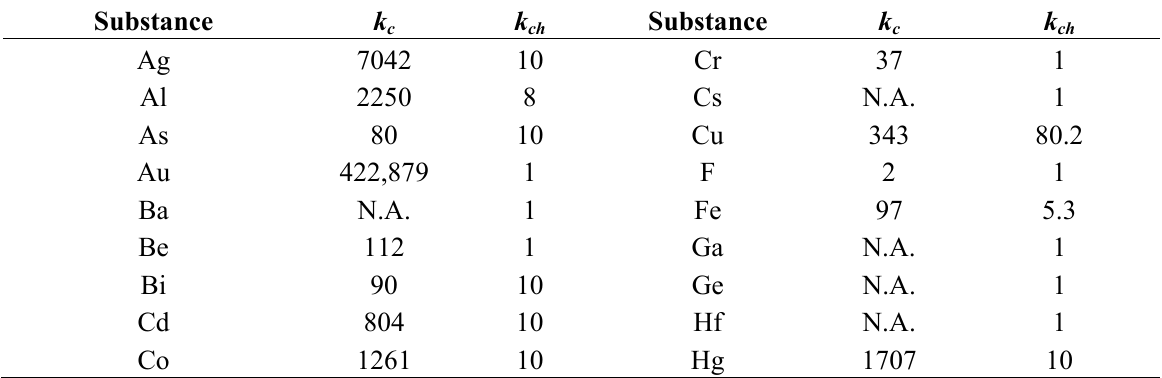
and k values—chemical and concentration exergy scaling ch c